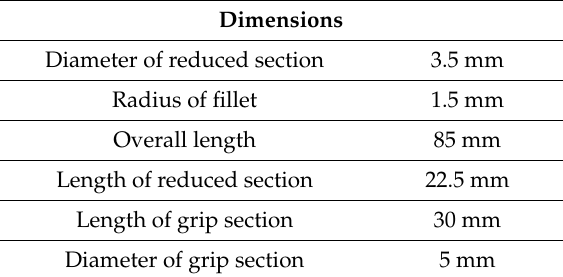
Figure 3. Geometry and dimensions of the tensile specimen for Slow Strain Rate Test (SSRT). Table 4. Parameters of the SSRT specimens.